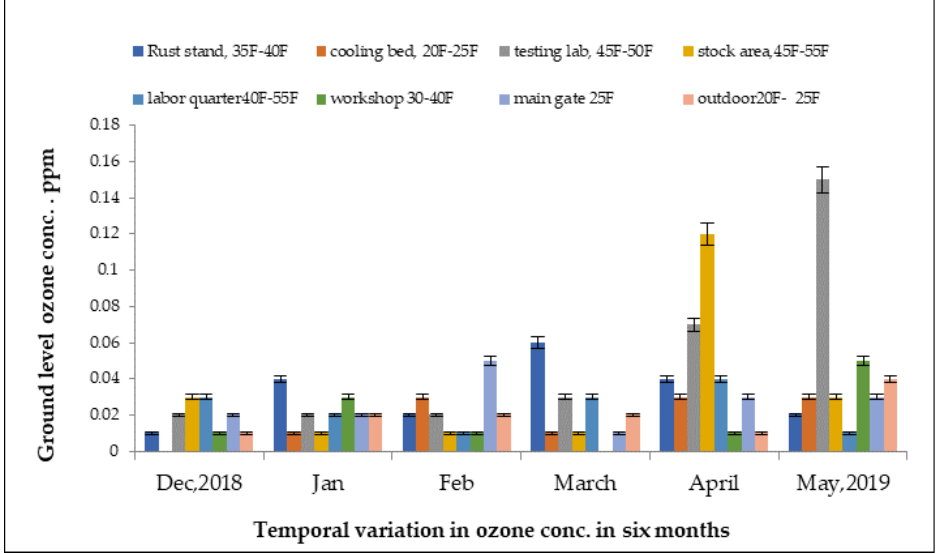
Figure 5. Variations in ground-level ozone concentrations in different units of steel industry from December 2018 to May 2019.